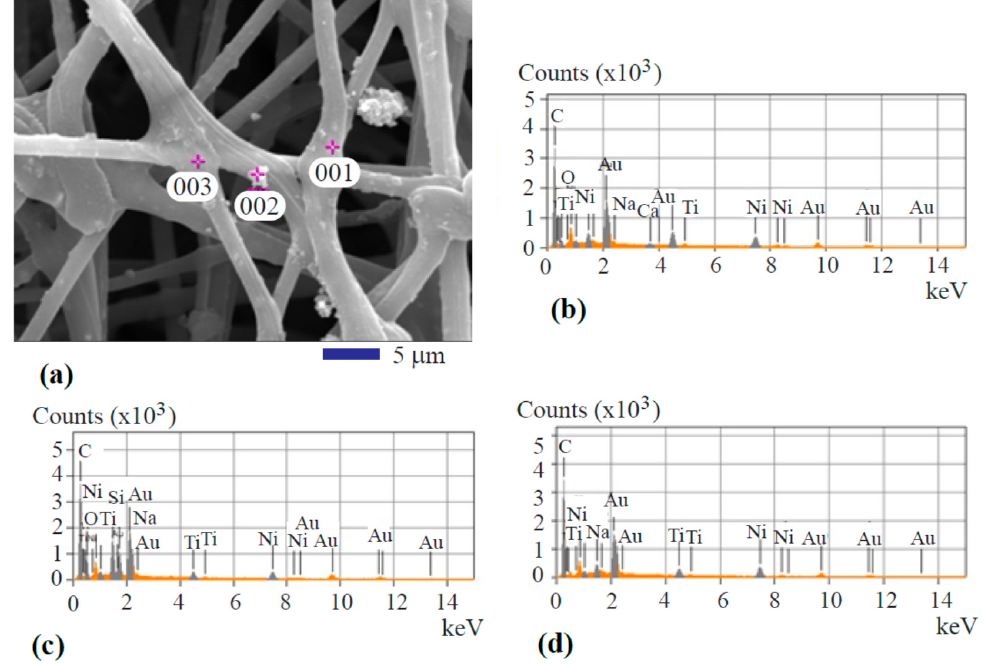
Figure 3. Spot analysis of the hydrothermal carbonization-coated fiber: ( a ) SEM image showing the analysis locations; ( b ) spot 001 spectrum; ( c ) spot 002 spectrum; and ( d ) spot 003 spectrum.